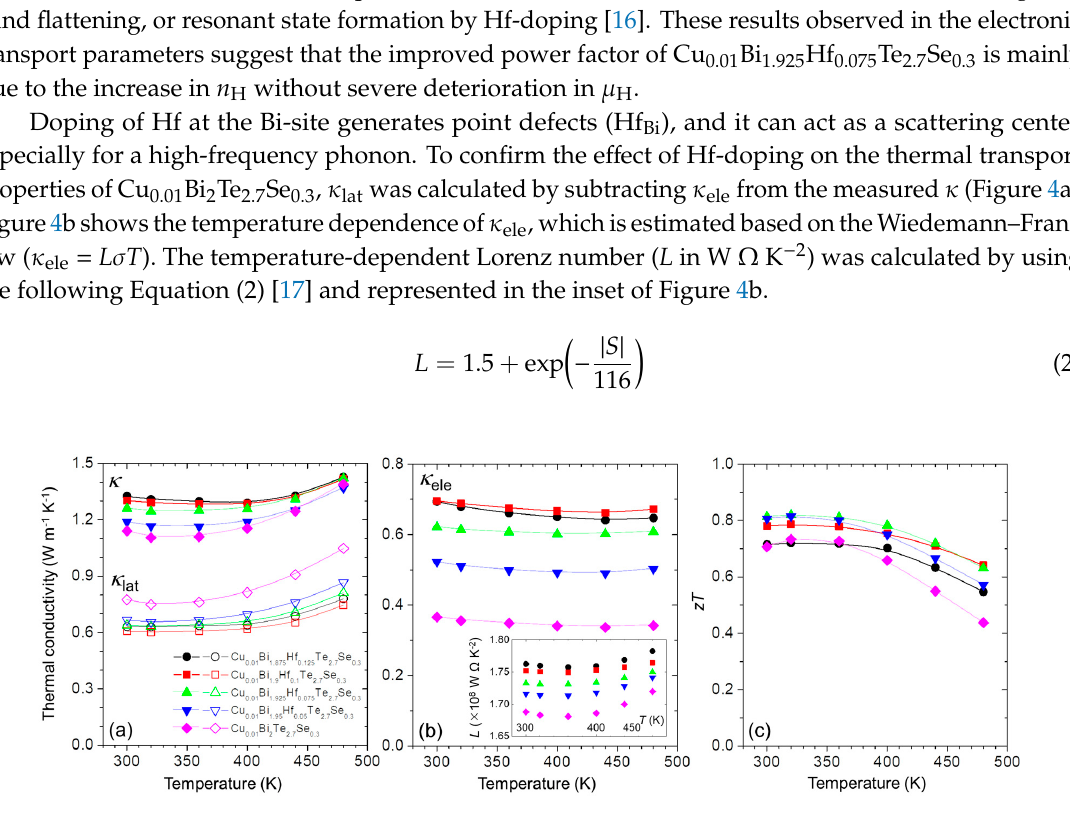
Figure 4. Temperature dependences of ( a ) total thermal conductivity ( κ ) and lattice thermal conductivity ( κ lat ); ( b ) electronic thermal conductivity ( κ ele ); and ( c ) a dimensionless figure of merit ( zT ) for the SPSed Cu 0.01 Bi 2- x Hf x Te 2.7 Se 0.3 ( x = 0, 0.05, 0.075, 0.1, 0.125) bulks. The inset of ( b ) shows the temperature ‑ dependent Lorenz number ( L ).